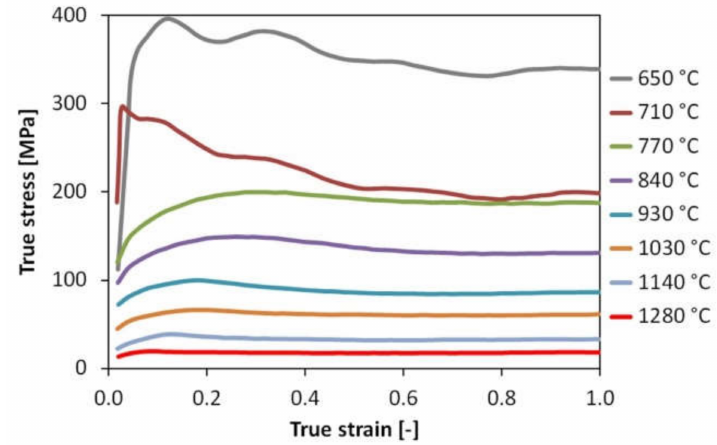
Figure 10. Influence of temperature on flow curves at a nominal strain rate of 0.02 s − 1